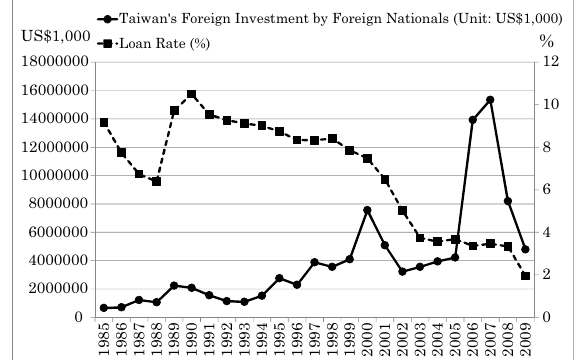
Fig. 1. Taiwan’s foreign investment by foreign nationals (unit: uS$1,000) and loan rate (%)